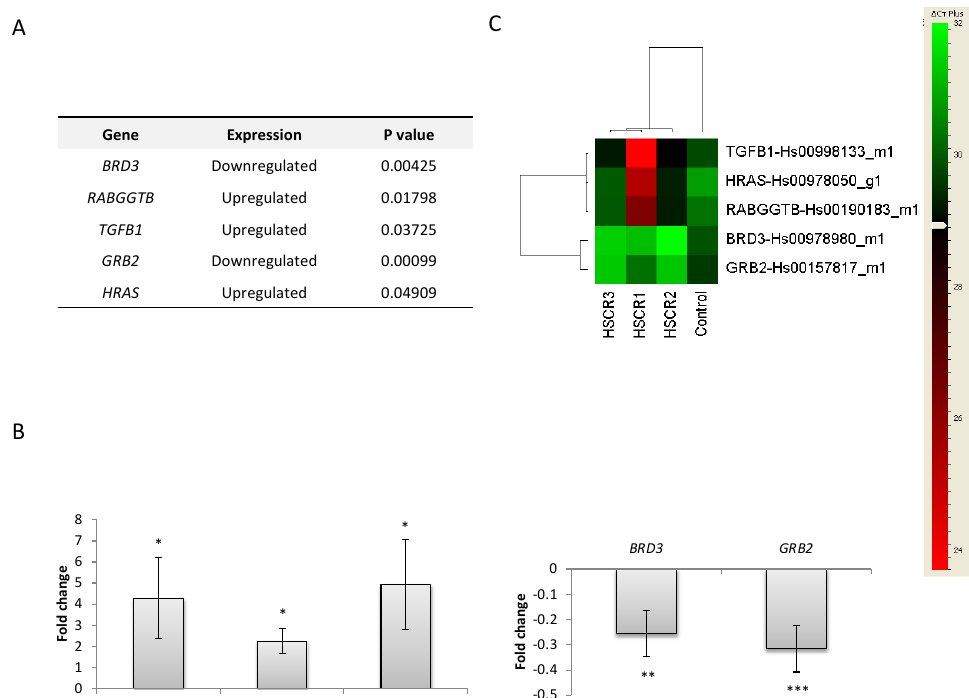
Figure 1. Genes with different expression levels in Hirschsprung disease (HSCR)-NLBs. ( A ) Genes that showed different expression levels between HSCR-NLBs and control NLBs. Analysis of differential gene expression of potential susceptibility genes for HSCR. ( B ) Analysis of differential gene expression relative to a fold change. ( C ) Heat map representative of the results. The heat map was generated using DataAssist v3.0 software (Life Technologies) and it represents the messenger RNA expression levels of such genes expressed in colon tissue from HSCR patients and controls. Genes were hierarchically clustered by Pearson correlation coefficient using average linkage. The color scale, representing Δ Ct, is shown on the right side. Green indicates genes with relatively decreased expression in HSCR, whereas red indicates genes with relatively increased expression in HSCR compared with the controls. * p value < 0.05, ** p value < 0.01 and *** p value < 0.001.